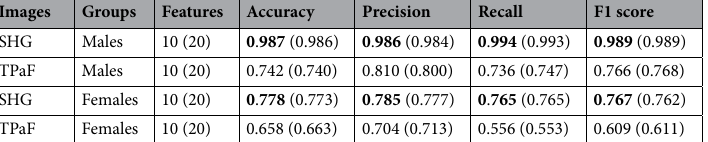
Table 3. Performance results (for OcnVEGFKO vs WT mice image patches) of an SVC (support vector classifier) with an RBF (radial basis function) kernel ( C = 3 ) with stratified 10-fold cross validation, using 10 or 20 persistence features (see main text) to predict whether an image patch in the test set is from a OcnVEGFKO or WT mouse. Classifiers with 10 features use only quadrant 2 of H 0 , whereas 20 features adds additional features from quadrant 1 of H 1 , with no improvement. All given measures are mean measures over 100 repeats. Numbers in bold show the best performance results (SHG images, 10 features).